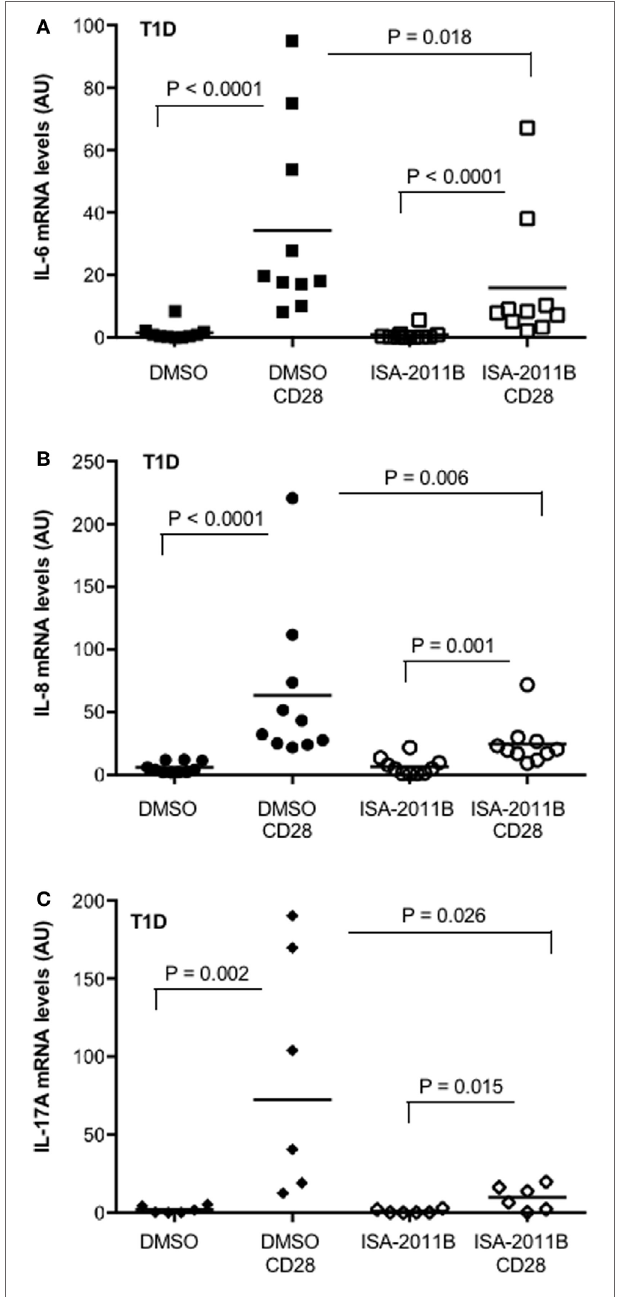
FigUre 6 | PiP5K α inhibition by isa-2011B impairs cD28-mediated upregulation of pro-inflammatory cytokines in primary T cells from type 1 diabetes (T1D) patients . (a) Primary T cells from T1D patients subjects were treated with DMSO or ISA-2011B (10 µg/ml) and stimulated for 6 h (a,B) or 24 h (c) with control isotype-matched mAb or crosslinked anti-CD28.2 Abs (T1D CD28). IL-6 (A), IL-8 (B) , and IL-17A (c) mRNA levels were measured by real-time PCR and values, normalized on GAPDH, expressed as arbitrary units. Median values: IL-6 ( n = 10), DMSO = 0.77, DMSO CD28 = 18.99, ISA-2011B = 0.26, ISA-2011B CD28 = 8.27; IL-8 ( n = 10), DMSO = 4, DMSO CD28 = 37.74, ISA-2011B = 4.75, ISA-2011B CD28 = 20.3; IL-17A ( n = 6), DMSO = 1.18, DMSO CD28 = 72.42, ISA-2011B = 0.27, ISA-2011B CD28 = 10.32. Lines represent mean values and P values are indicated where significant